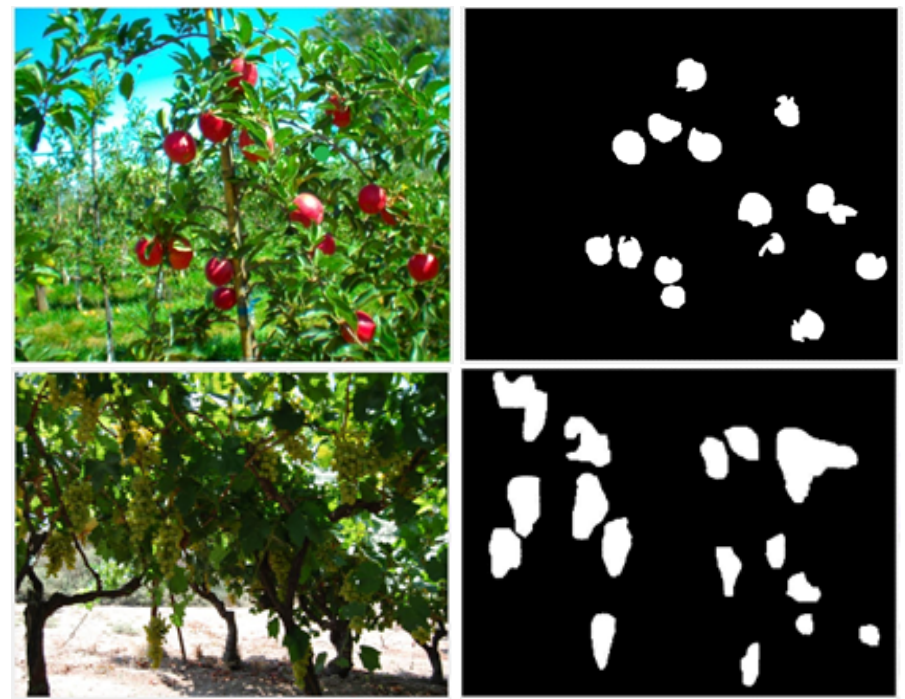
Figure 2. Apple ( top ) and grape ( bottom ) RGB image ( left ) and ground truth ( right )